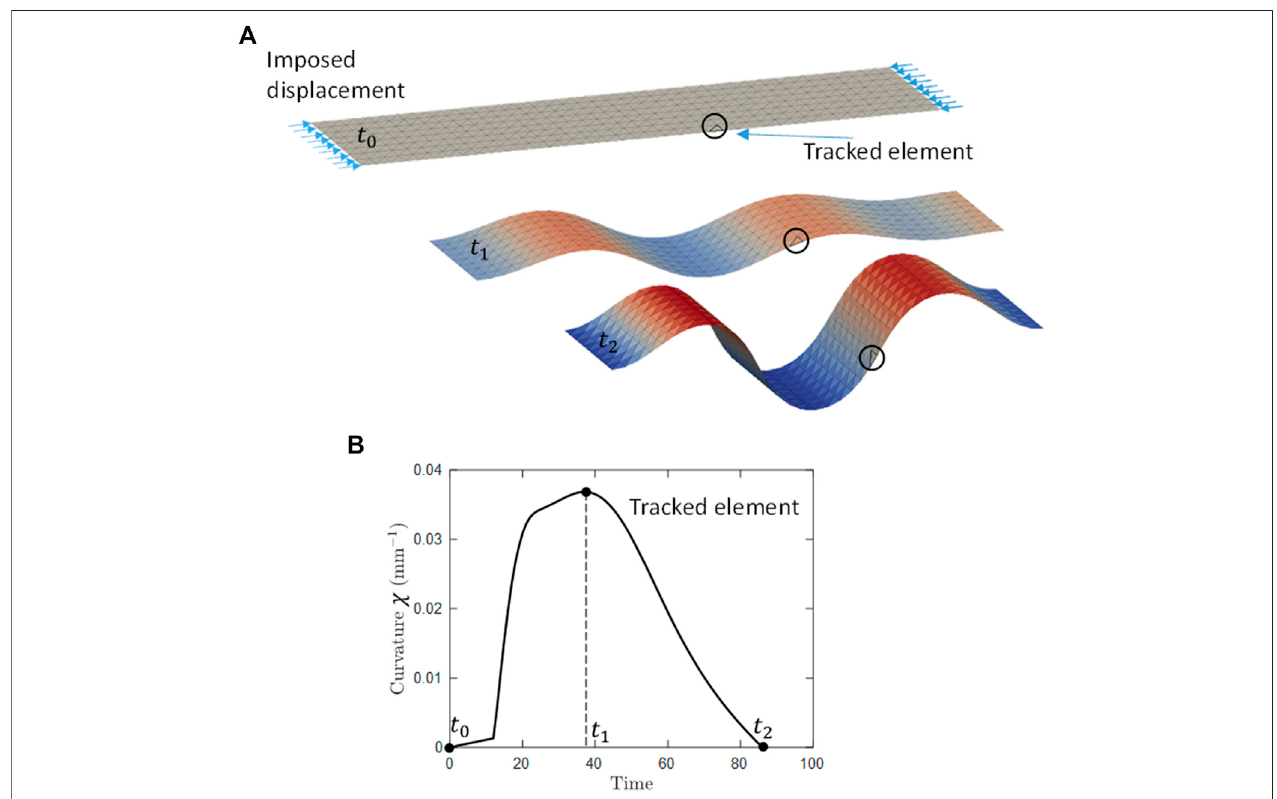
FIGURE12|(A) Out-of-planedeformationobtainedduringin-planecompressionofawovenreinforcement. (B) Curvatureasafunctionoftimeofanelementofthe reinforcement.